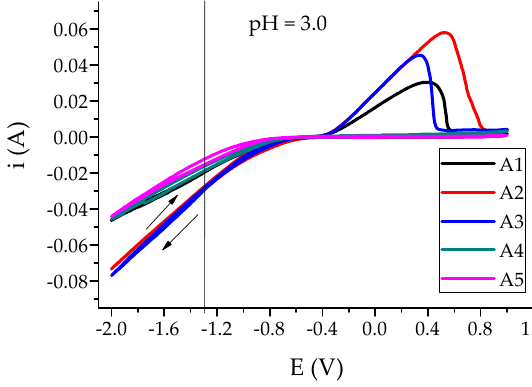
Figure 2. Cyclic voltammograms for “A” solutions (v = 40 mVs − 1 ).